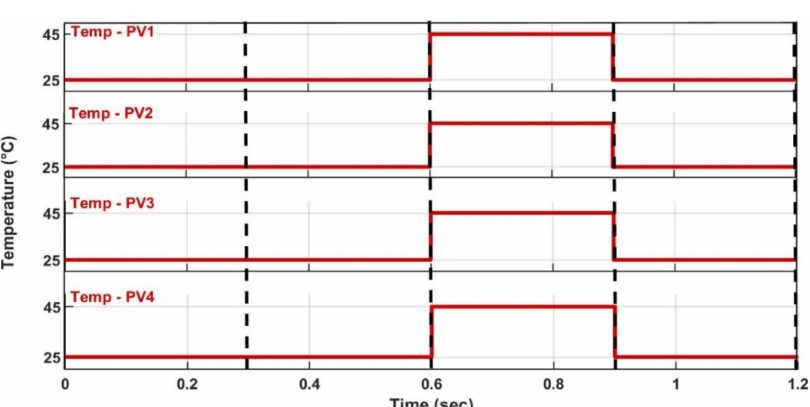
Figure 43. Varying irradiance profile.